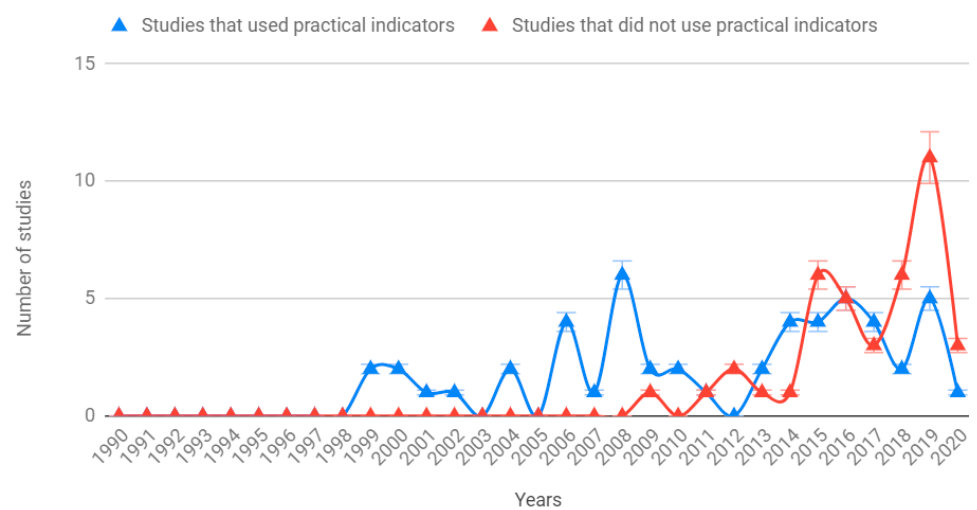
Figure 4. Temporal evolution of studies on biodiversity indicators, which address (blue) and do not address (red) practicability of the indicators and data collection methods applied. Note that our review includes studies until February 16 (i.e., the year 2020 is incomplete).